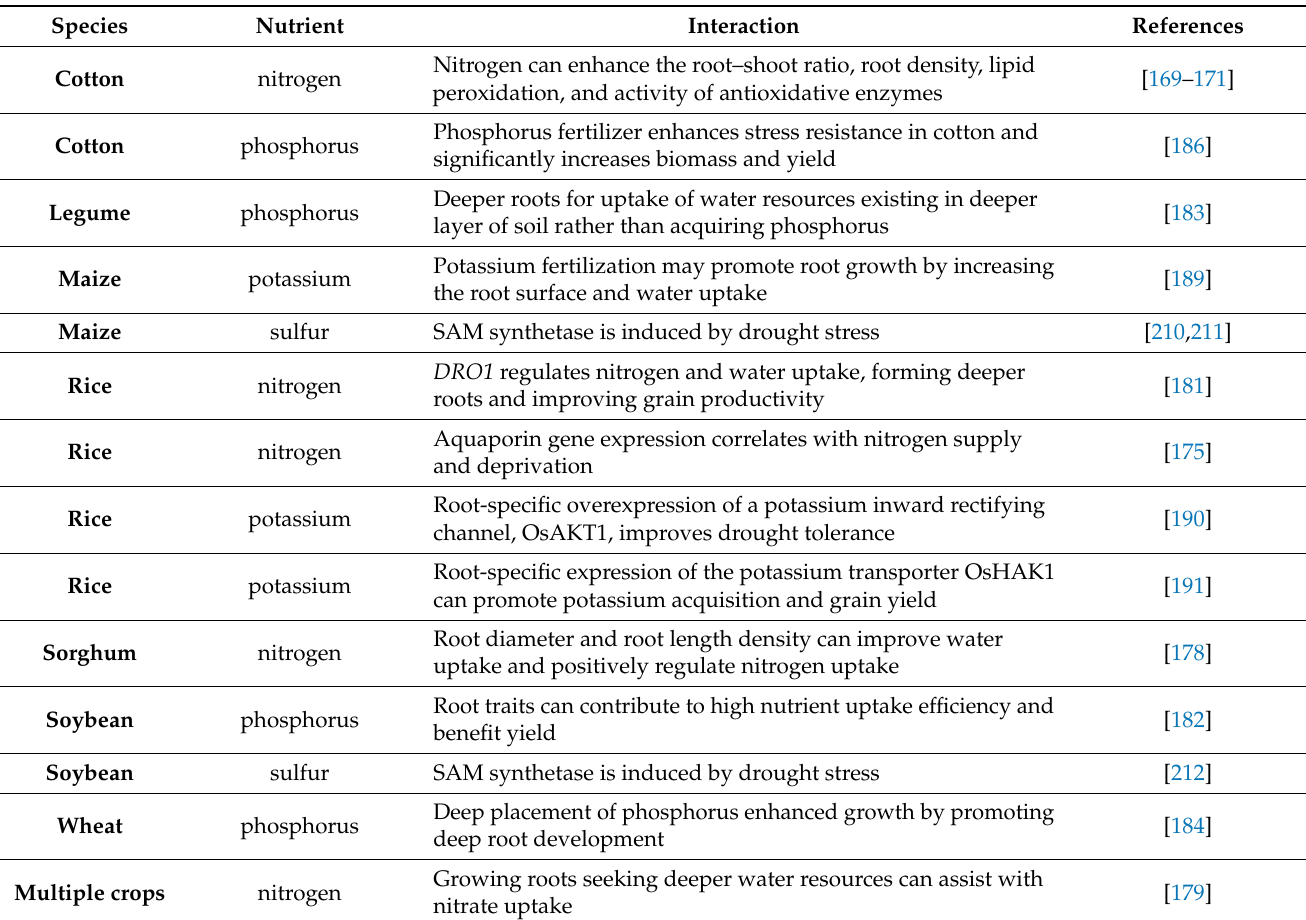
Table 1. Interactions of roots and nutrients in crops under drought